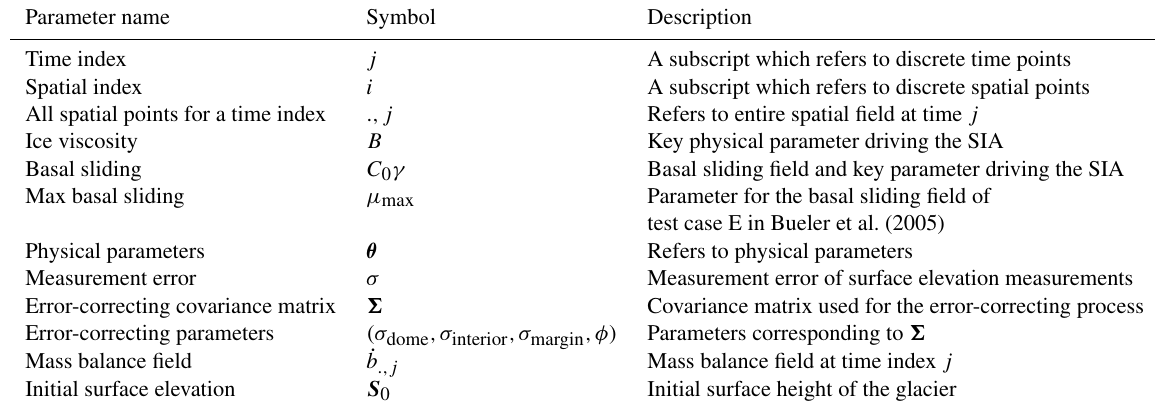
Table 1. A summary of main parameters and notation